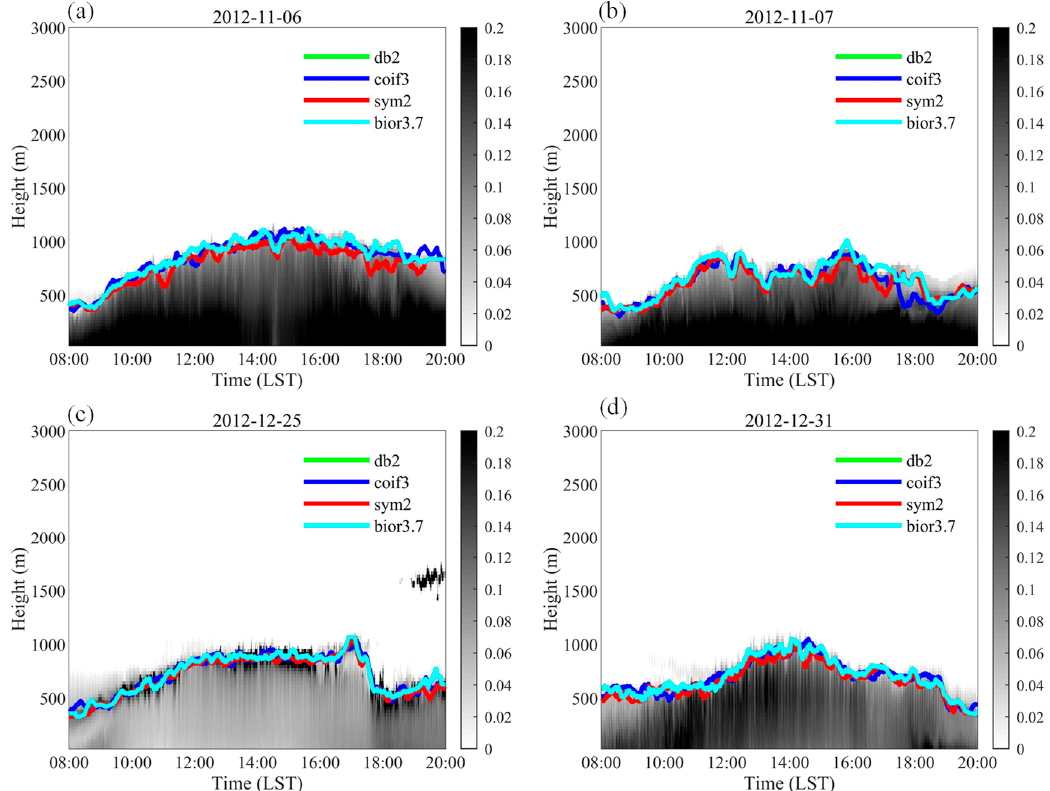
Figure 1. The diurnal variations of mixed layer (ML) heights (solid lines) calculated by the 2D wavelet method based on different wavelet filters: ( a ) November 6; ( b ) November 7; ( c ) December 25 and ( d ) December 31, 2012. (The grey shades show the extinct coefficients, unit: hm − 1 ; and the effect of boundary layer cloud on the extinct coefficients were also observed in (c)). The influences of cumulus on the lidar observations is also shown in (c). The grey shades show the extinct coefficients, unit: hm − 1 .